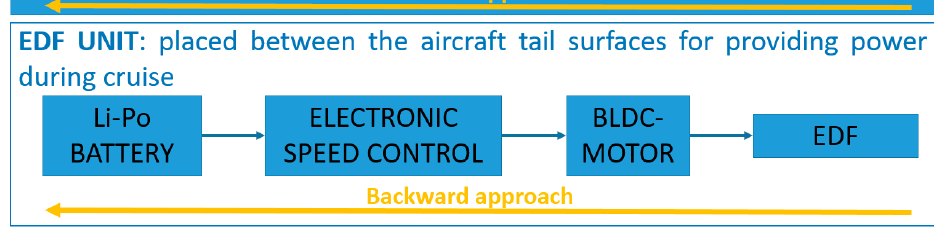
Figure 1. Electric power system workflow.